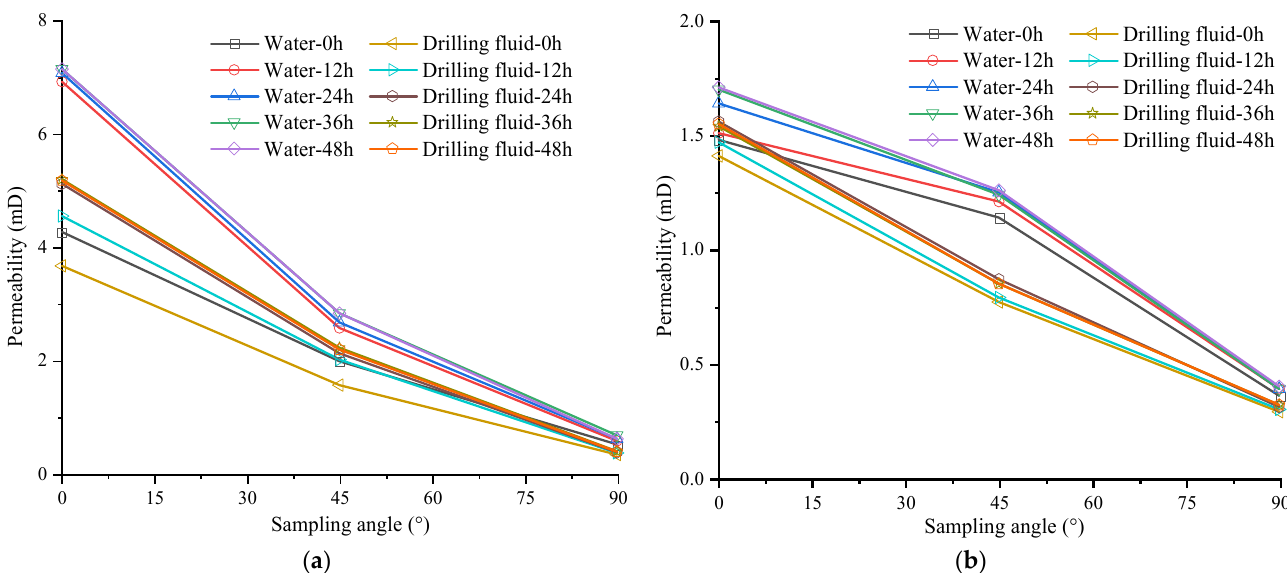
Figure 7. Permeability under the different sampling angles: ( a ) The relationship between permeability and sampling angle of lamellar shale, the lamina density with sampling angle of 0° is 1, the lamina density with sampling angle of 45° and 90° is 2; ( b ) the relationship between permeability and sampling angle of bedding shale.